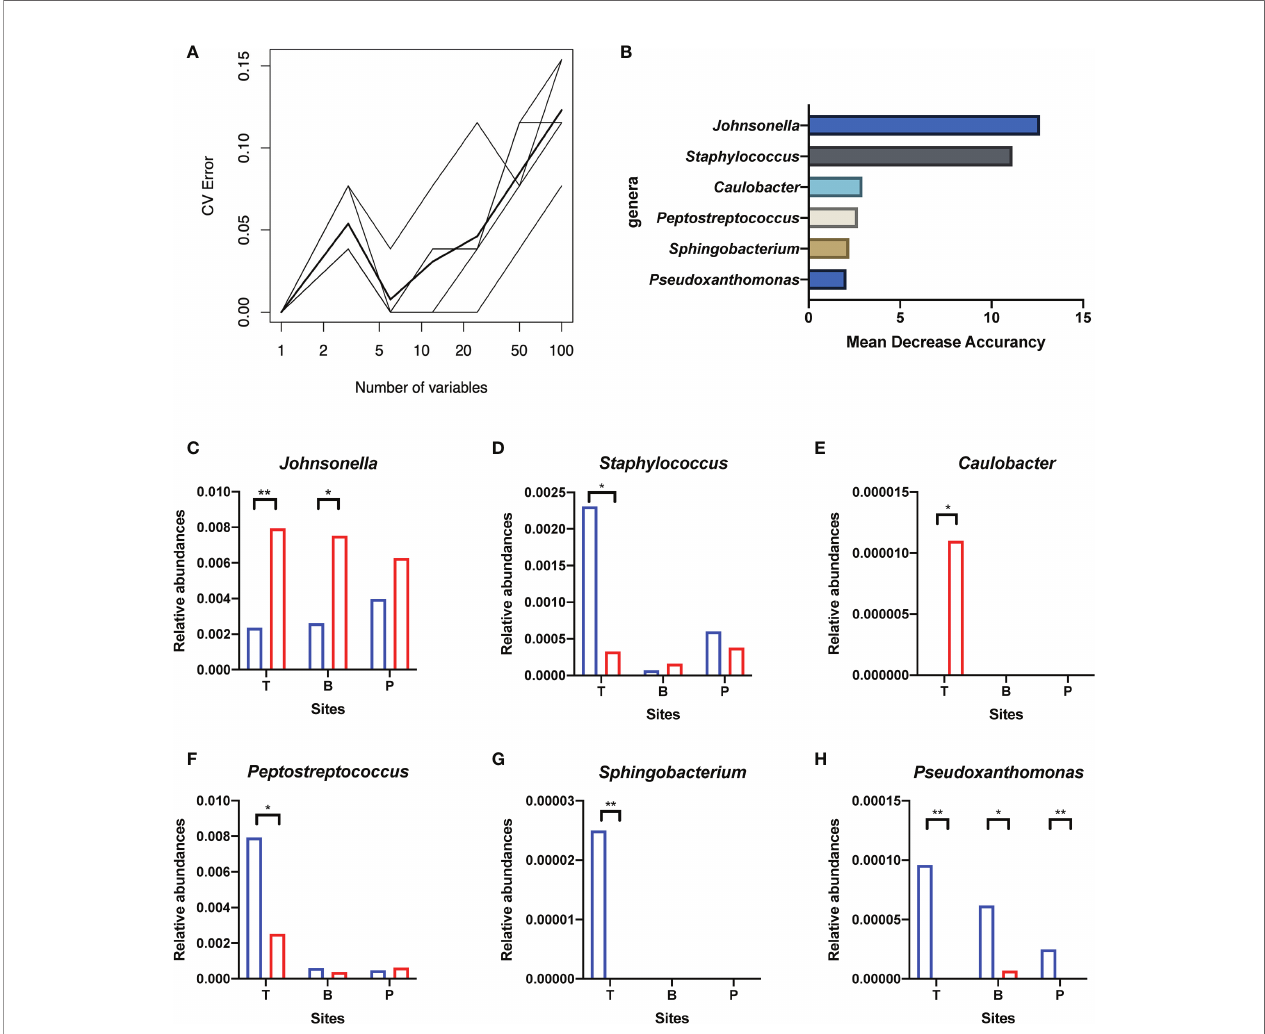
FIGURE 5 | Screening of candidate “ related bacteria ” for the hypertrophic or healthy status of tonsils within the tonsil surface microbiota and their distribution in different niches. (A) The result of ten-fold cross-validations of the random forest model analysis within the tonsil surface microbiota. The ordinate is the prediction error rate, and the abscissa is the variable numbers; the thinner broken line is the result of each cross-check, and the thicker broken line is the average of the fi ve repetitive cross-check results. In the fi gure, the abscissa value that meets criteria of greater than 1 and corresponds to the lowest error rate of the random forest model is six. That is, the number of bacteria that exert the greatest impact on the accuracy of the classi fi ed random forest model is six. (B) Top six genera of Mean Decrease Accuracy within the tonsil surface microbiota. Higher Mean Decrease Accuracy indicates higher the importance of the particular genus in the classi fi cation random forest model. The top 6 genera in the ranking of the Mean Decrease Accuracy value were selected as the candidate “ related bacteria ” for tonsillar hypertrophy and health status in the tonsil surface microbiota. (C – H) Distribution of the six candidate “ related bacteria ” in niches of tonsil surface, in saliva, and in supragingival plaque. *p < 0.05, **p <